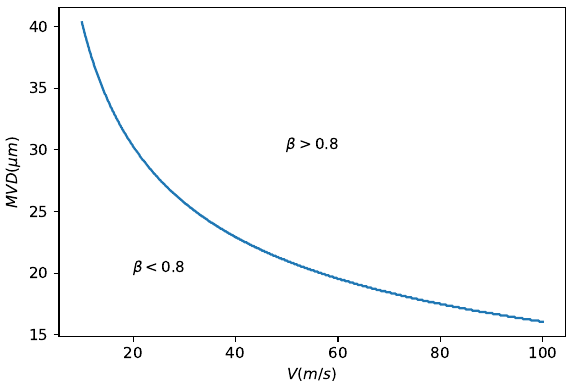
Figure 13. Collection efficiency in function of the airspeed and of the